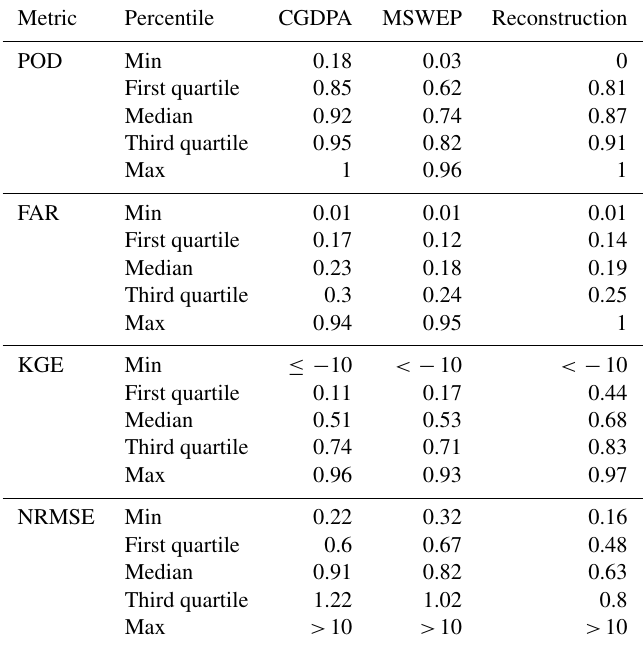
Table 4. Validation of the reconstructed precipitation in all grids at a national scale. The benchmark dataset is the CMPA. POD: probability of detection, FAR: false alarm rate, KGE: Kling–Gupta efficiency, NRMSE: normalized root mean squared error. In northern (latitude > 40 ◦ N) and western (40 ◦ N > latitude > 27 ◦ N and longitude < 100 ◦ E) China, only data in May–September are used for validation.